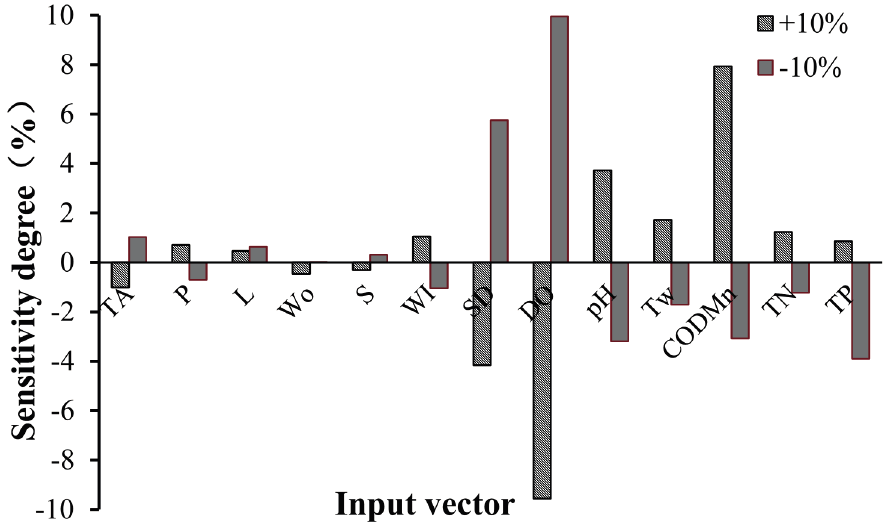
Figure 5. Sensitivity analysis for input vectors of the SVM